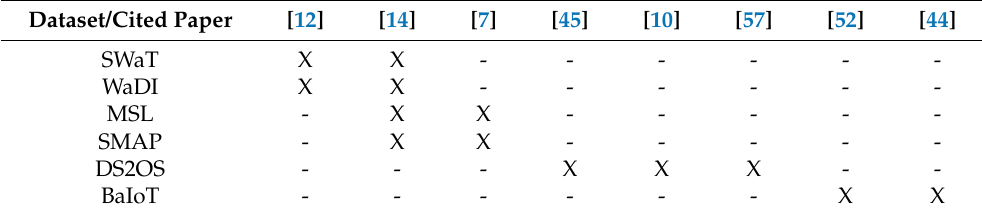
Table 3. Data-sets and the surveyed AD works that used them. An ’X’ indicates if a work utilized a data-set.